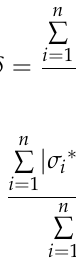
Figure 14. Comparison between experimental data and model data. ( a ) W = 2 MPa; ( b ) W = 4 MPa; ( c ) W = 6 MPa.